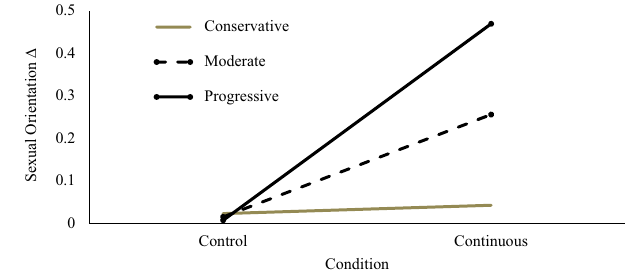
Figure 1. Change in sexual orientation self-rating as a function of condition ( control or continuous ) and political orientation ( conservative, moderate , or progressive ). Higher scores indicate a greater shift in sexual orientation from pre- to post-manipulation.